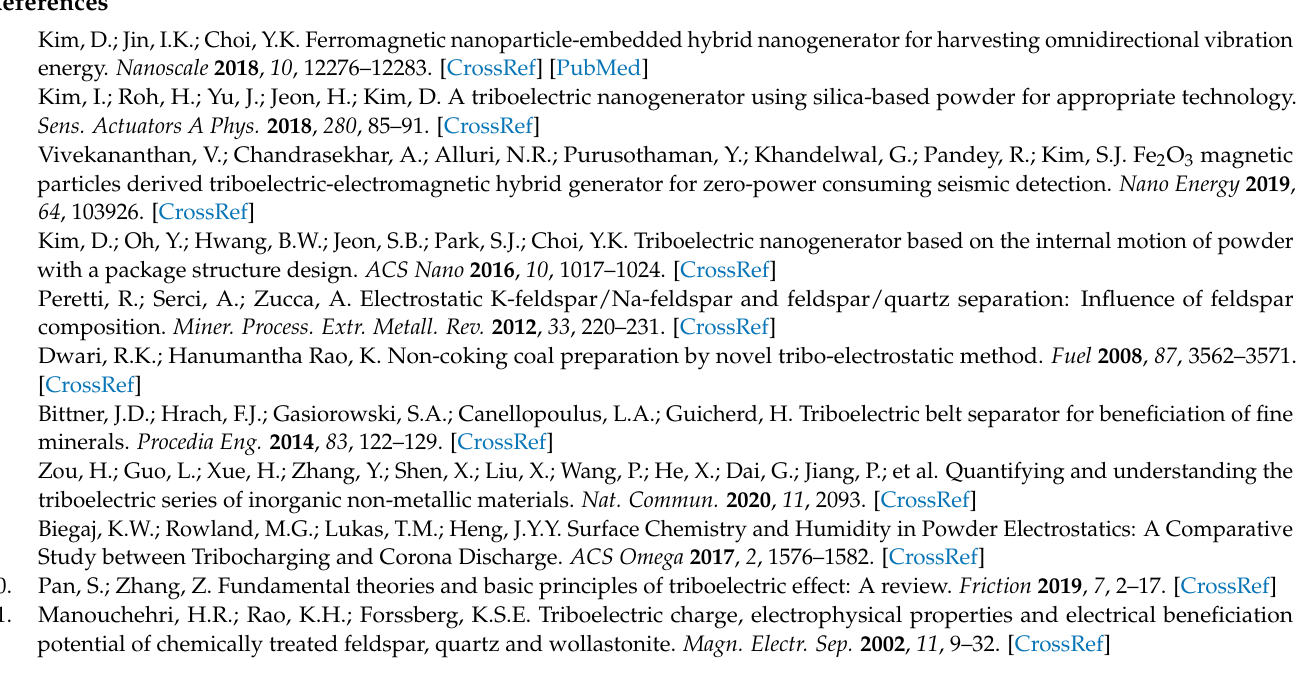
Figure A1. Charged (positive: green bars, negative: red bars) and neutral fractions (grey bars) of Saxolith 8 for ( a ) 0.5-m copper helix attached and ( b ) 1-m copper helix attached.